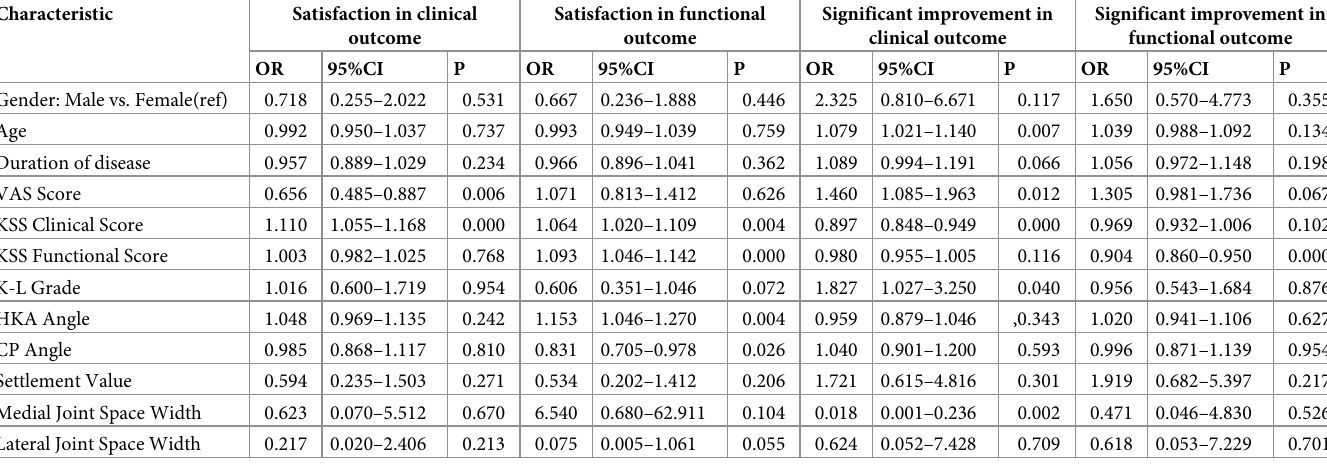
Table 1. Odds ratios of Bivariate logistic regression analyses for outcome of interest versus patient clinical and radiological characteristic.